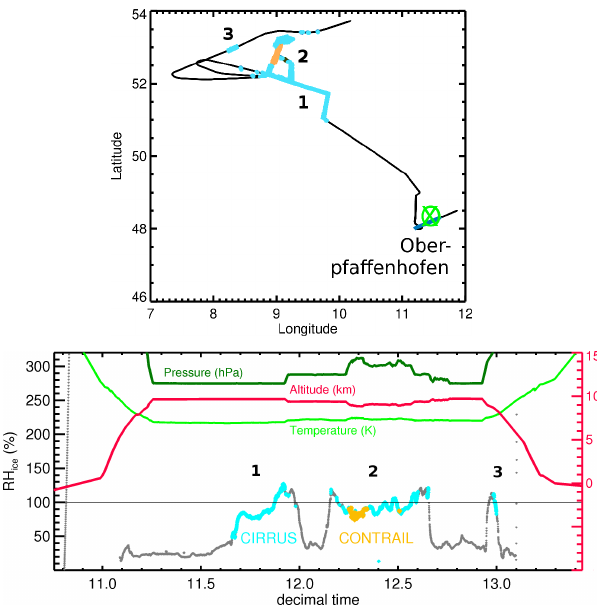
Fig. 7. Vertical profiles of the ice crystal number N ice for different size intervals in the 2. cirrus (turquoise) period of the 1st flight on Nov. 17, 2008, including the A340 contrail (coloured by age, see legend in bottom panel). Cloud particle instrumentation: FSSP – Forward Scattering Spectrometer Probe and CPI – Cloud Particle Imager, for more information see Section 2.